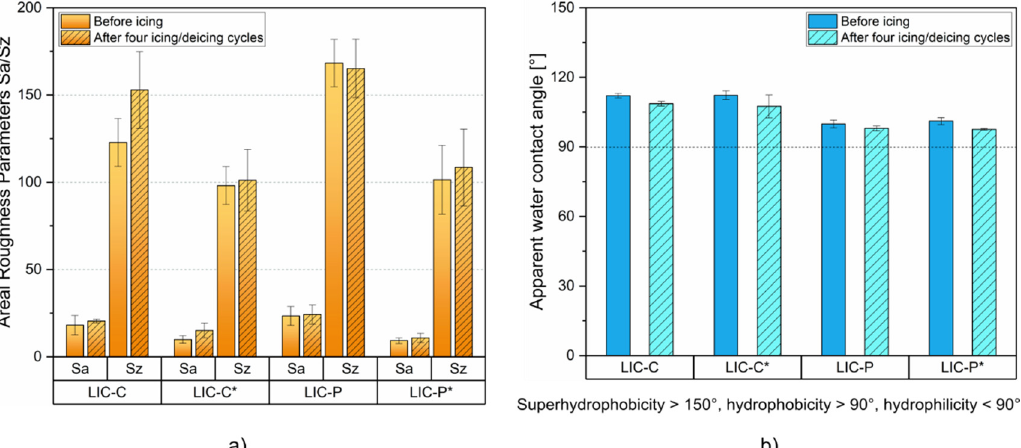
Figure 9. Comparison of surface properties before and after four icing/deicing cycles for LICs: ( a ) areal roughness parameters (Sa and Sz), and ( b ) apparent water contact angles.